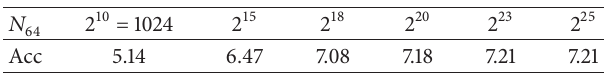
Table 6: The results of experiments (data are transmitted through four 32-bit high-performance ports and one 64-bit ACP).